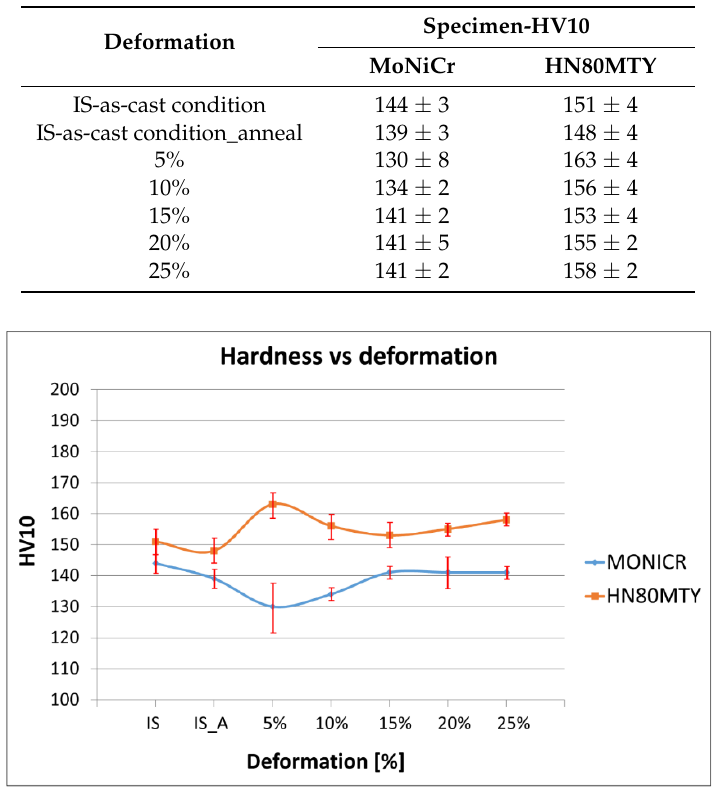
Figure 12. The hardness of nickel alloys. Legend: IS—initial state, IS_A—annealed initial state. Electron Backscatter Diffraction Analysis (EBSD) of As ‐ Cast and Deformed Microstructures